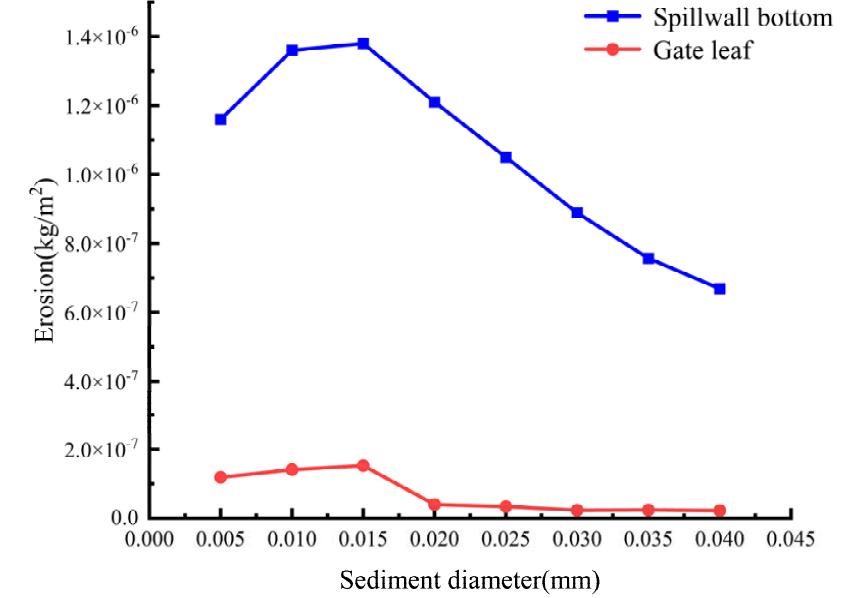
Figure 8. Relationship between erosion and sediment